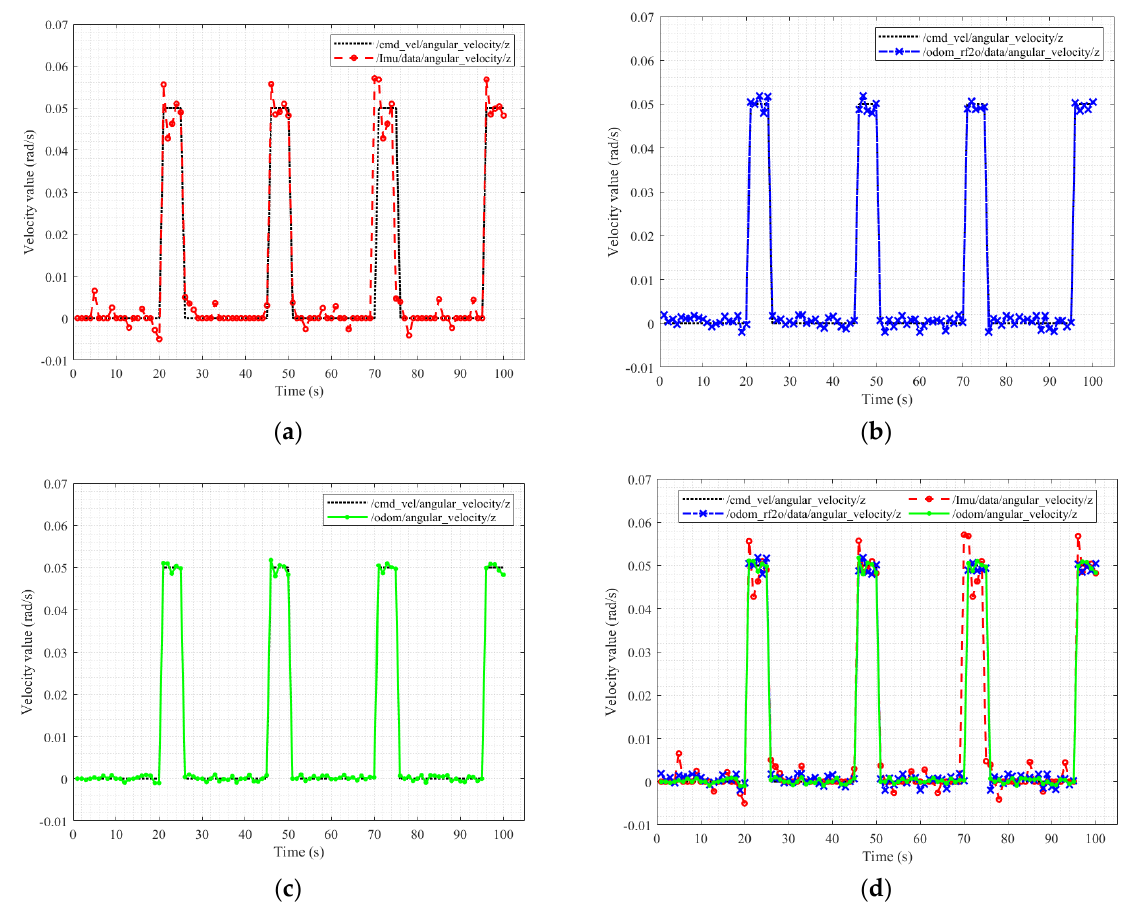
Figure 10. Comparison of angular velocity values of Owlbot in a walking square test. Angular Z-axis velocity data measured by the ( a ) IMU; ( b ) LiDAR; ( c ) IMU and LiDAR fusion. ( d ) Comparison.